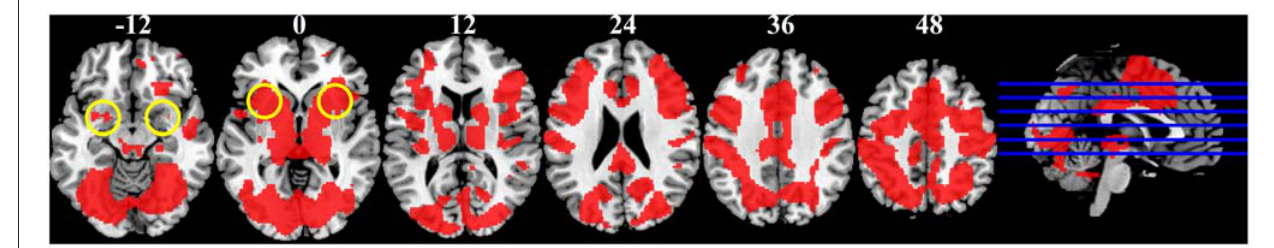
FIGURE 5 | Regions significantly active across the three reputation conditions during reputation learning identified by conjunction analysis ( p < 0.001, uncorrected for multiple comparisons; shown in red) . Numbers above slices indicate z coordinates in MNI space. Yellow circles at z = − 12 and z = 0 indicate approximate locations of the amygdala and the anterior insula, respectively.